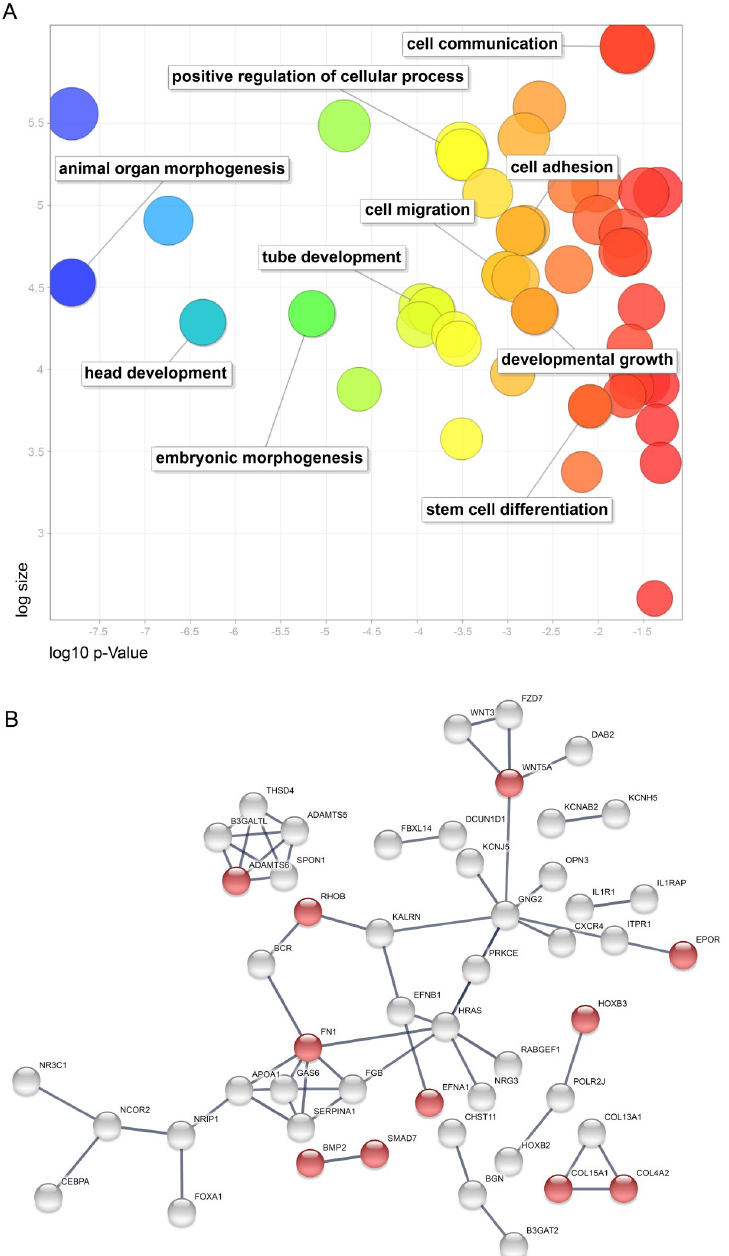
Fig 5. mRNA targets of PUM1 and PUM2 upregulated in the polysome during cardiomyogenesis. (A) Gene ontology analysis of mRNA targets of PUM1 and PUM2 upregulated on day 4 of in vitro cardiomyogenesis. The figure shows a REVIGO scatterplot of the representative clusters of GO terms obtained with g:Profiler. In the two- dimensional graph, the log10 p-value of each GO result after REVIGO analysis is plotted on the x-axis, and the terms are scattered based on the log size along the y-axis. The bubble color indicates the provided p-value: bluer colors represent smaller p-values, whereas orange and red colors represent larger p-values. (B) Network analysis of mRNA targets of PUM1 and PUM2 upregulated on day 4 of cardiomyogenesis. Functional enrichments in circulatory system development (FDR 1.99e-05) are represented in red. Interaction Score: Highest confidence (0.900), STRING.